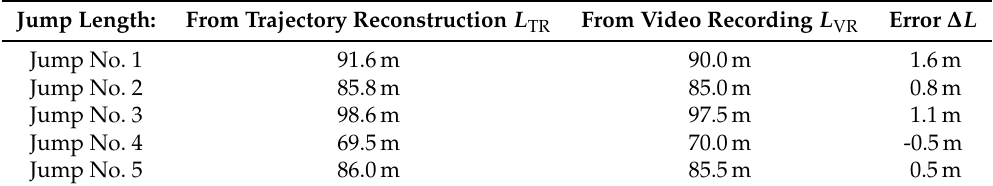
Table 7. Comparison between jump length obtained from the trajectory reconstruction results (proposed method) and video recordings